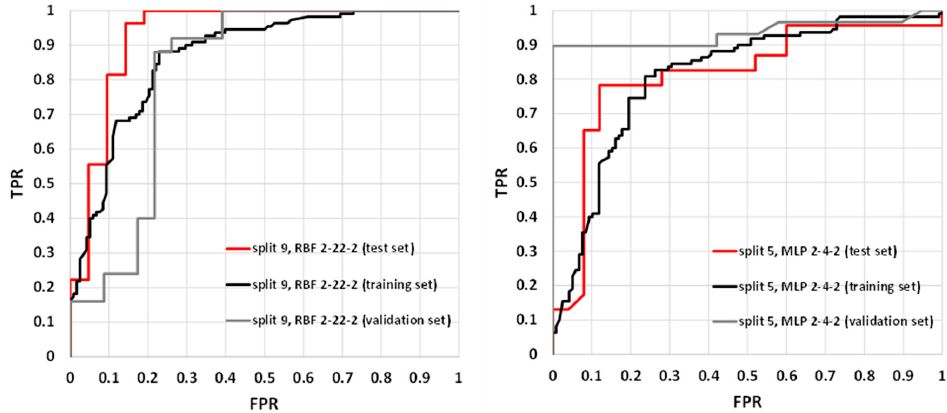
Figure 3. Receiver operating characteristics (ROC) plots for RBF 2-22-2 (split 9) and MPL 2-4-2 (split 5) models.